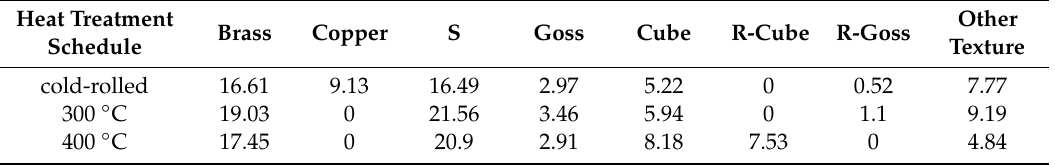
Table 2. Textures volume fraction of 2195 Al ‐ Li alloy sheets after isothermal annealing at different temperatures (%).